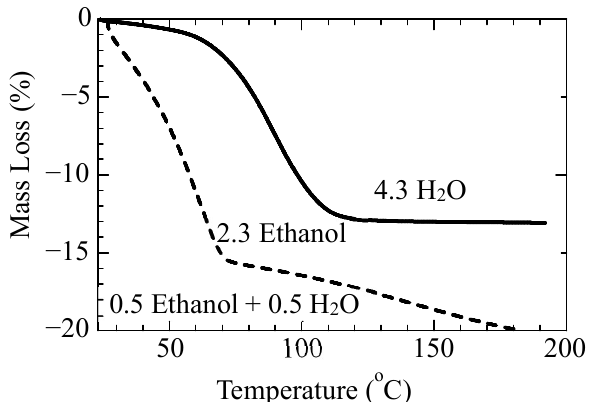
Figure 3. Optical micrograph of crystals obtained using cooling crystallization based on the aqueous solution.